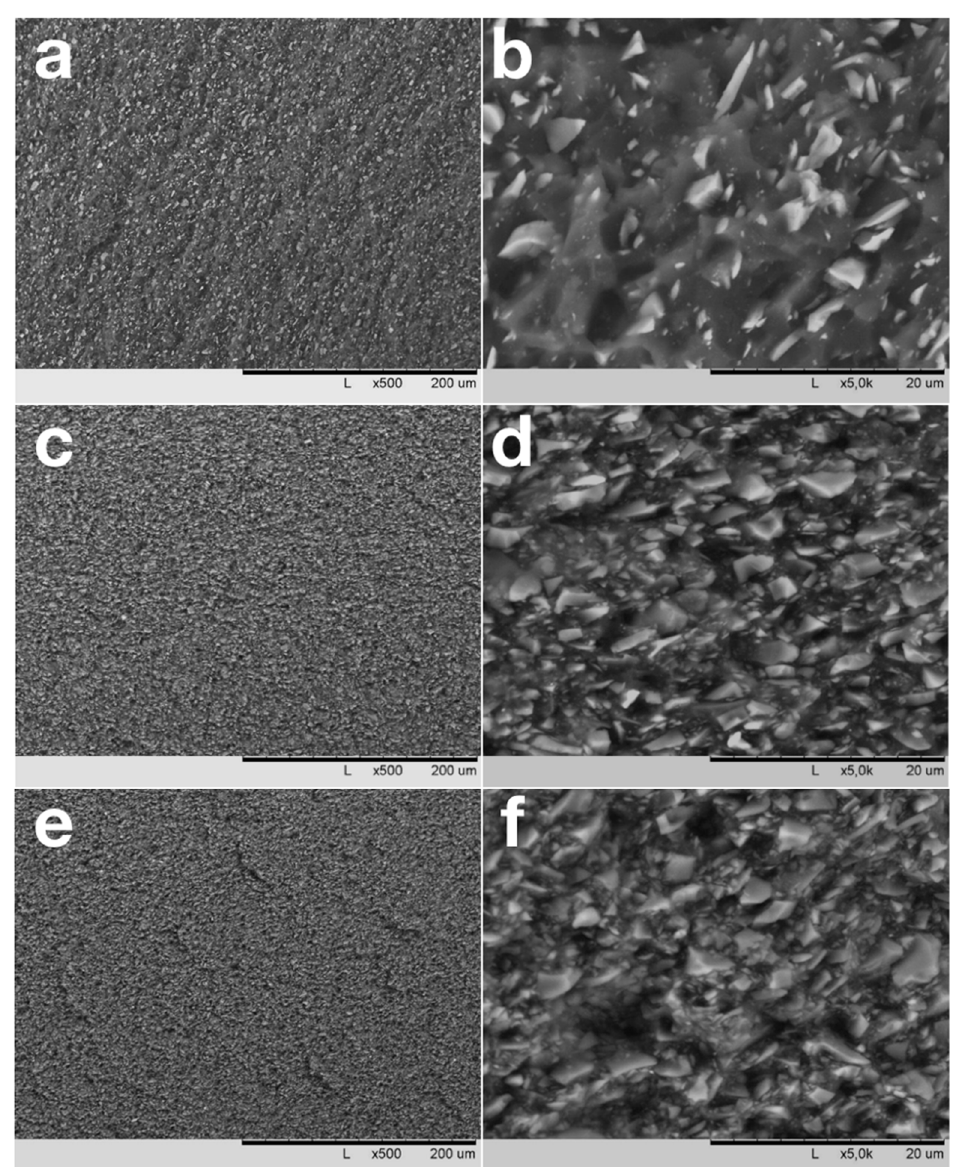
Figure 5. SEM images of carbonized samples with filling degrees of 50 ( a , b ), 250 ( c , d ) and 450 PHR